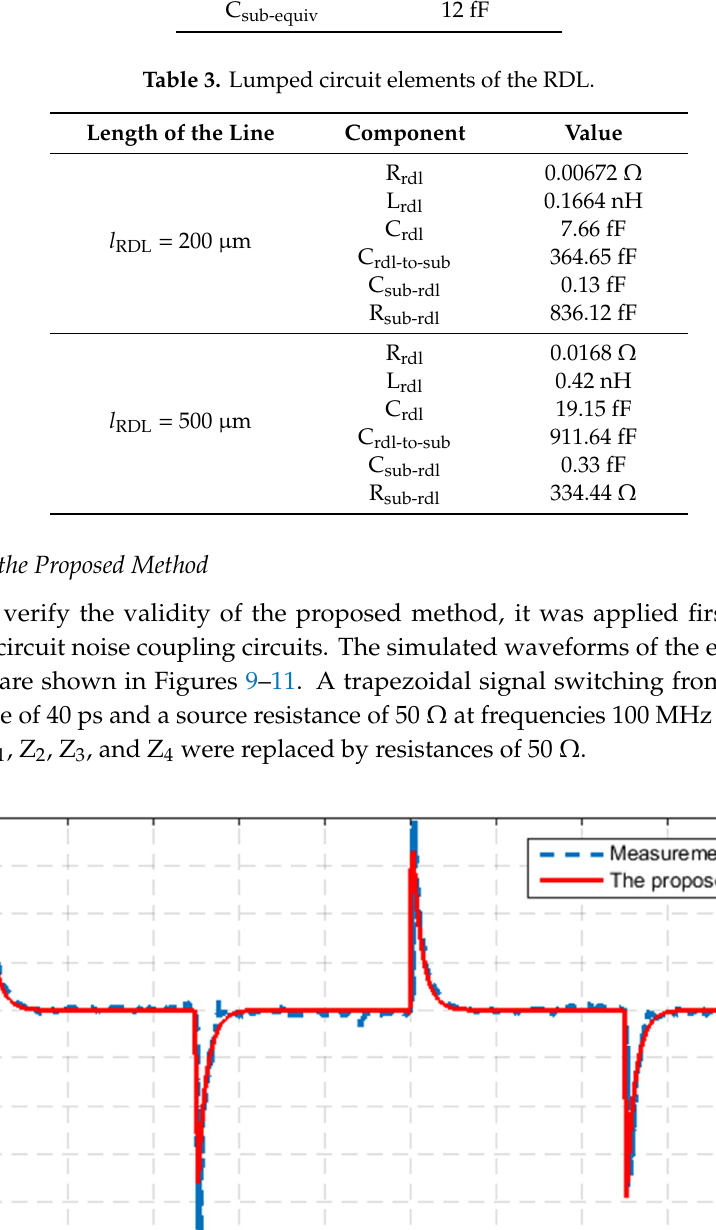
Table 3. Lumped circuit elements of the RDL.